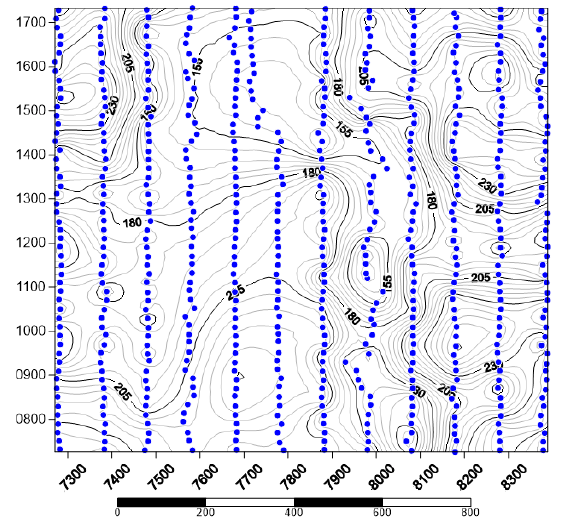
Figure 4. The measurement location on the topographic map.